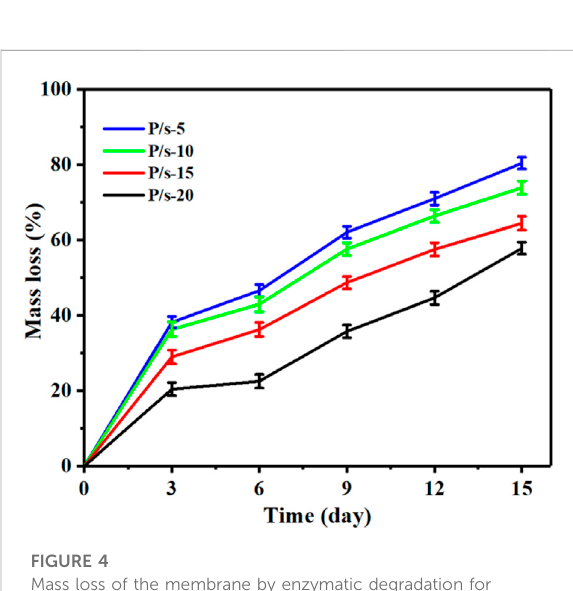
FIGURE 4 Mass loss of the membrane by enzymatic degradation for 15